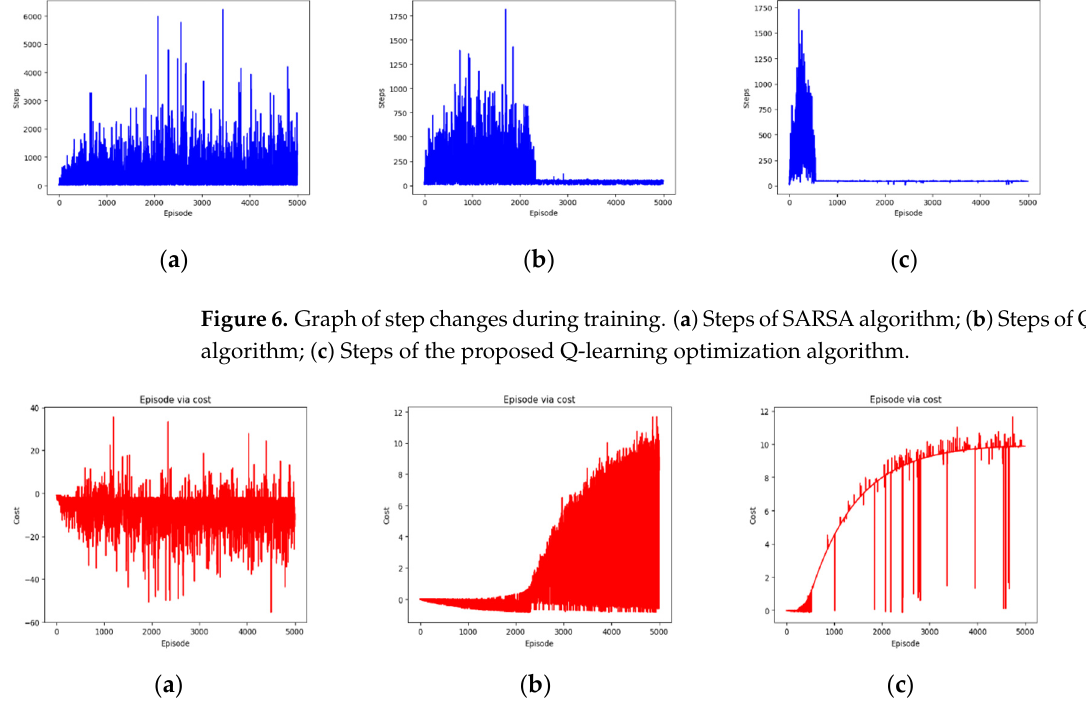
Figure 7. Change graph of cumulative rewards during training. ( a ) Cumulative reward of the SARSA algorithm; ( b ) Cumulative reward of the Q-learning algorithm; ( c ) Cumulative reward of the proposed Q-learning optimization algorithm.